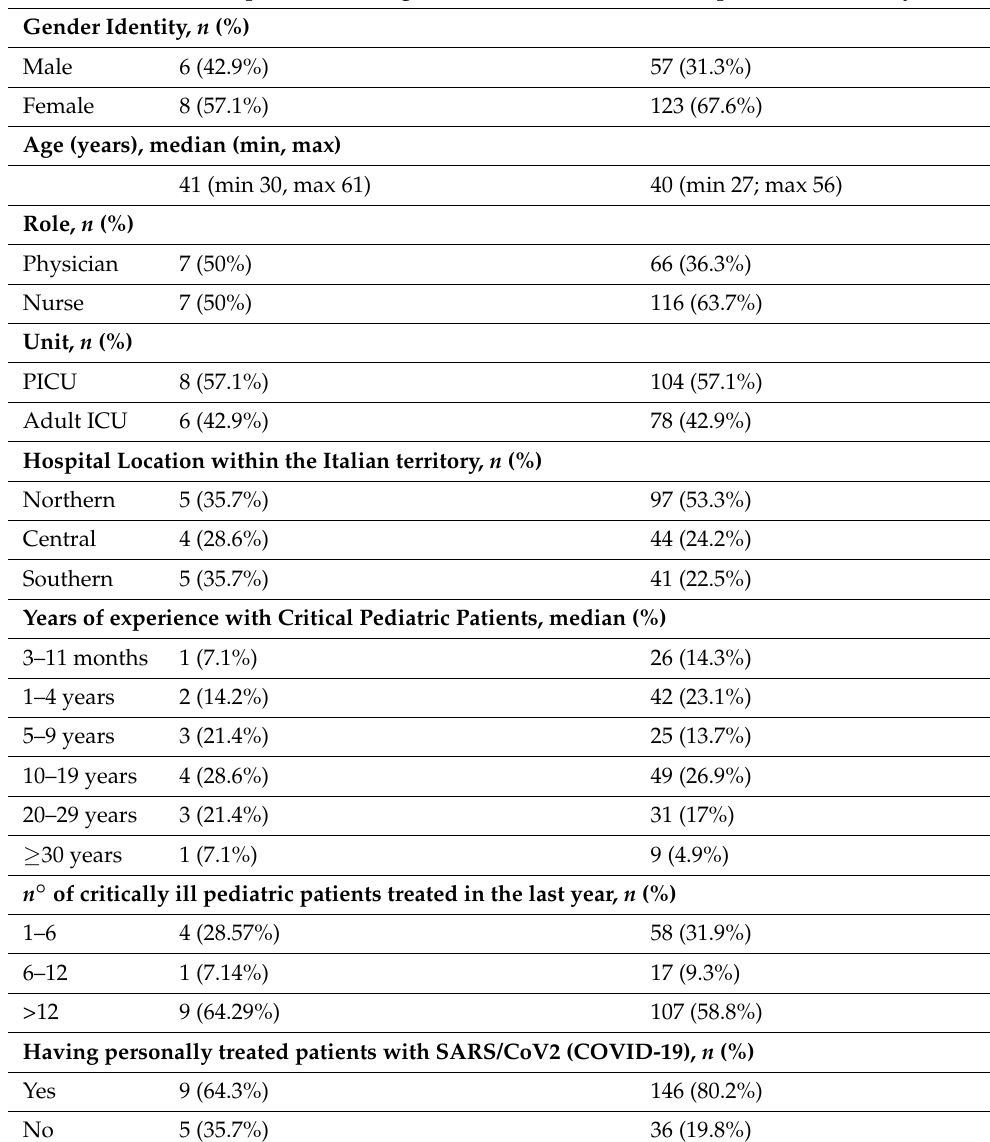
Table 1. Demographics. Demographics of participants in Pre-Test and Cognitive Interview ( n = 14) and the web-based Survey ( n =